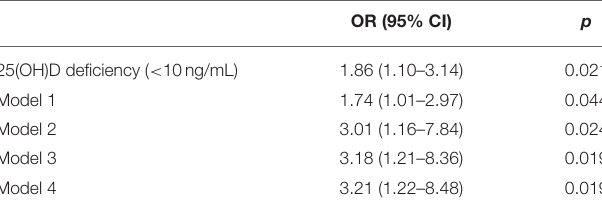
TABLE 3 | Binary logistic regression analysis of predictors for poor functional outcome (mRS 3-6) at 3 months.